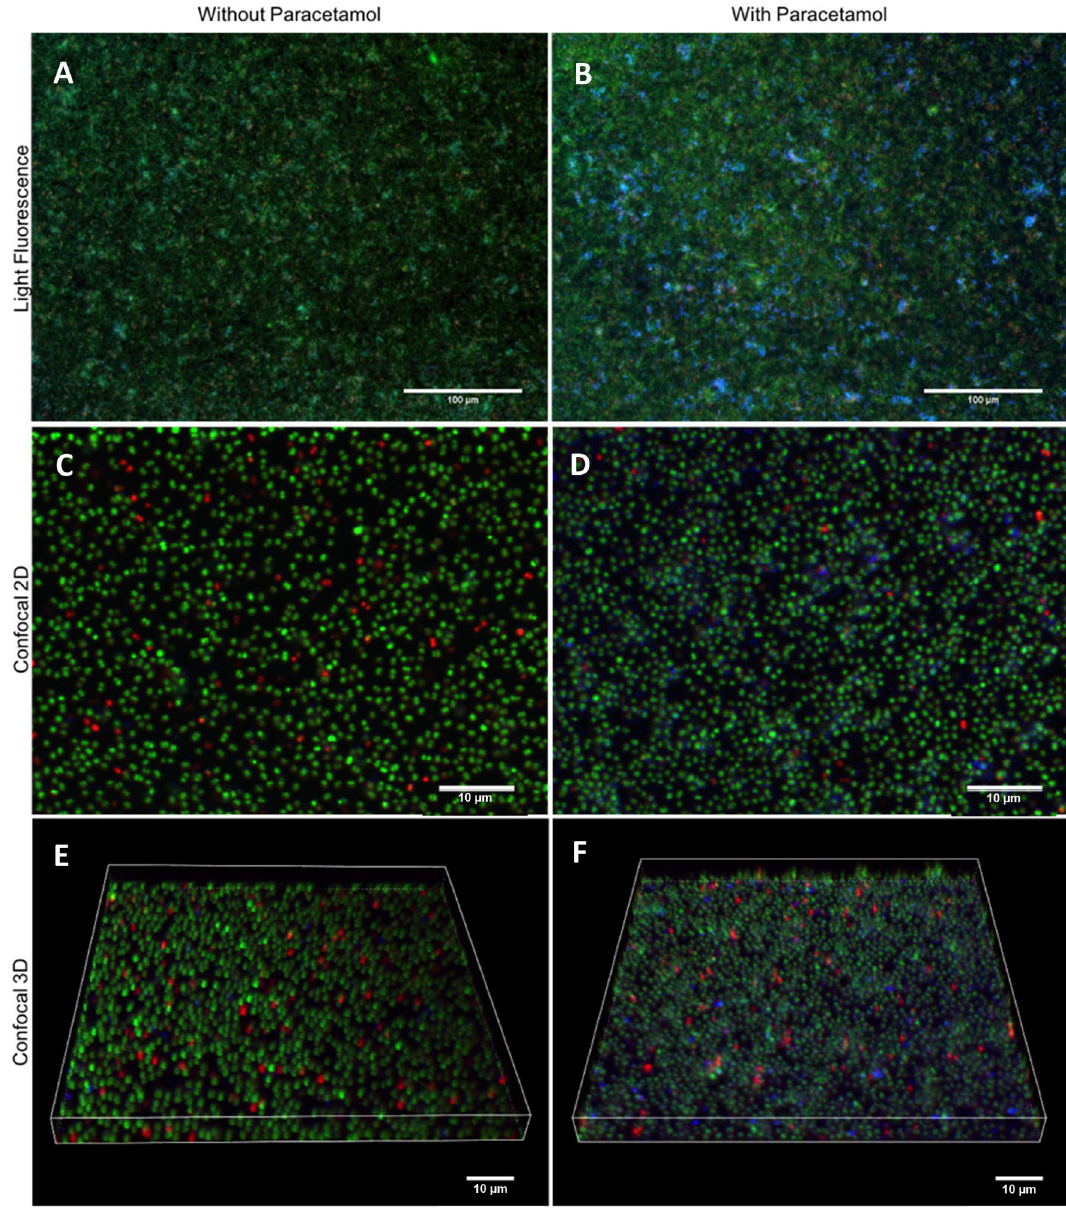
Figure 4. The effect of paracetamol on staphylococcal biofilm matrix composition. Biofilms of S. aureus strain M116 (CC8, ST239) were grown at 37 °C without ( A , C , E ) and with ( B , D , F ) paracetamol (2 μg/ml). Fluorescent images of stained biofilms were captured using inverted light fluorescence microscopy ( A , B ) and confocal laser scanning ( C – F ) microscopy with corresponding three-dimensional volume rendering ( E , F ) acquired using a Nikon A1R + microscope with NIS-Elements Advanced Research software (Version 4.50; Nikon Instruments). For all images, green fluorescence (SYTO 9 stained) are live bacteria, red fluorescence (PI stained) are dead bacteria and/or eDNA, and blue fluorescence (WGA stained) are N-Acetylglucosamine. All images are representative of three separate into a sterile flat-bottom 96-well polystyrene tissue culture plates (Costar no. 3596; Corning Inc., Corning, NY) containing a serial dilution (0.5, 1, 2, 4, 8, 16, and 32 μg/mL) of paracetamol in 190 µL of IMDM. The plates were incubated at 37 °C for 24 h with continuous shaking at 150 rpm. Bacterial growth was then measured using a microplate reader (BMG technologies, Ortenberg, Germany) at OD 600nm . Afterwards, the visible biofilms which had formed in the wells were washed once with 200 µL of sterile phosphate-buffered saline (PBS) containing 1% BSA and 0.05% azide. Biofilms were then air dried and stained with 50 µL of 1% crystal violet in distilled water for 2 min. Excess crystal violet was removed by washing the plates with distilled water for five times. The stained biofilm was then dissolved in 200 µL of extraction solution (50% dH 2 O, 40% EtOH, 10% acetyl acid) and the absorbance of crystal violet measured at OD 490nm in the Epoch 2 microplate reader.